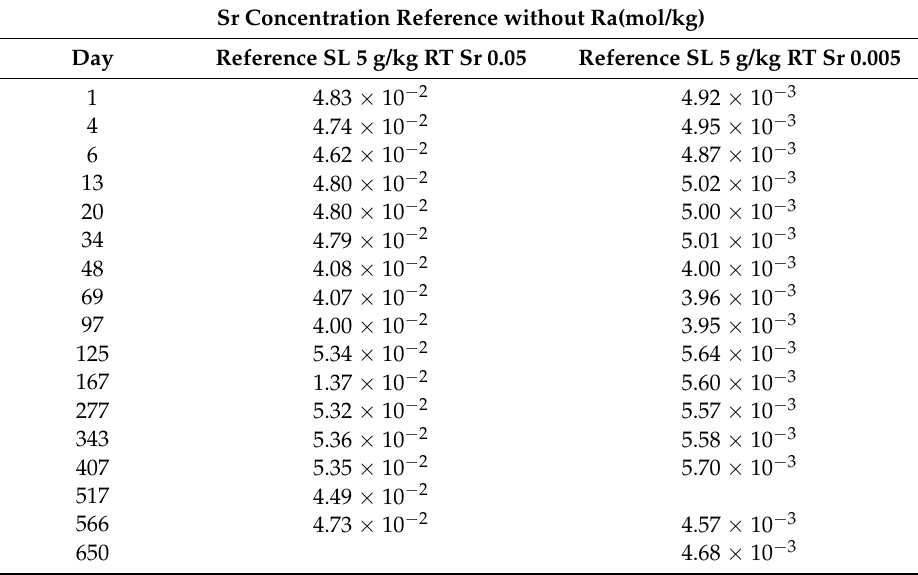
Table A12. Sr concentration of Reference experiments with Sr in the aqueous solution at 23 ◦ C.